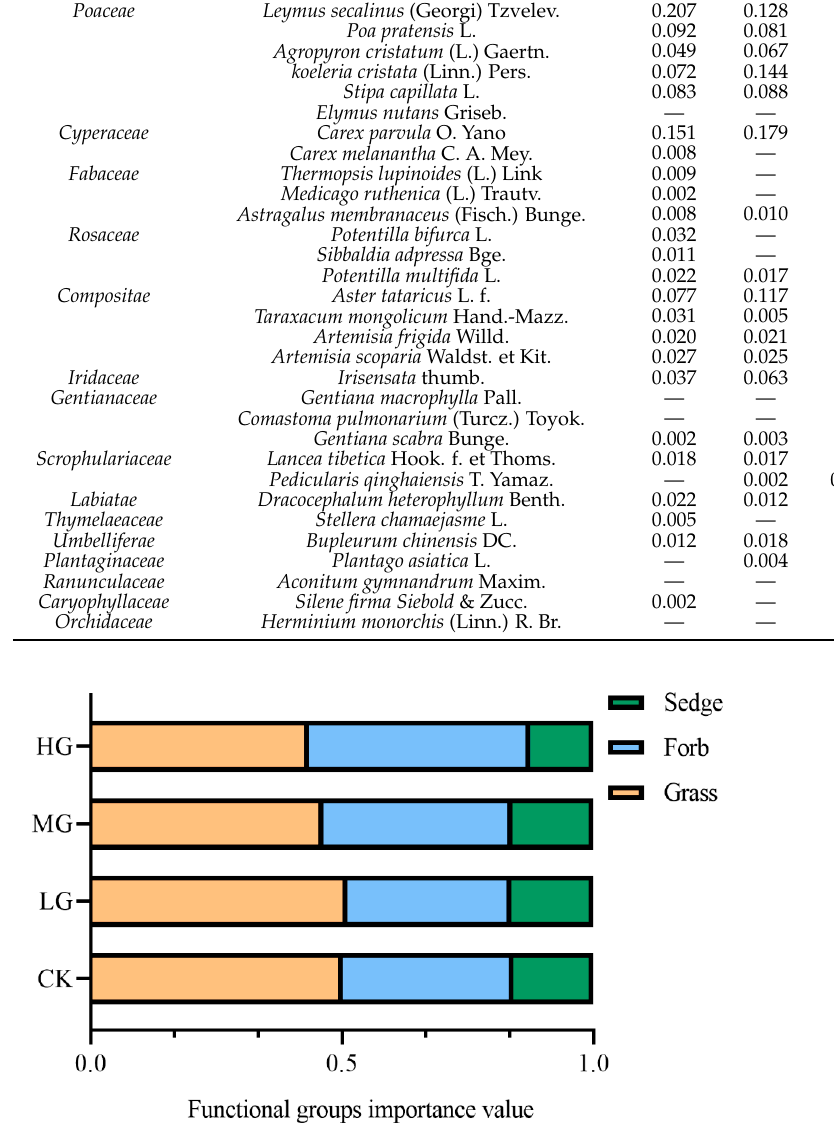
Table 2. The effects of grazing intensity on plant diversity indexes. CK, no grazing; LG, light grazing; MG, moderate grazing; HG, heavy grazing.